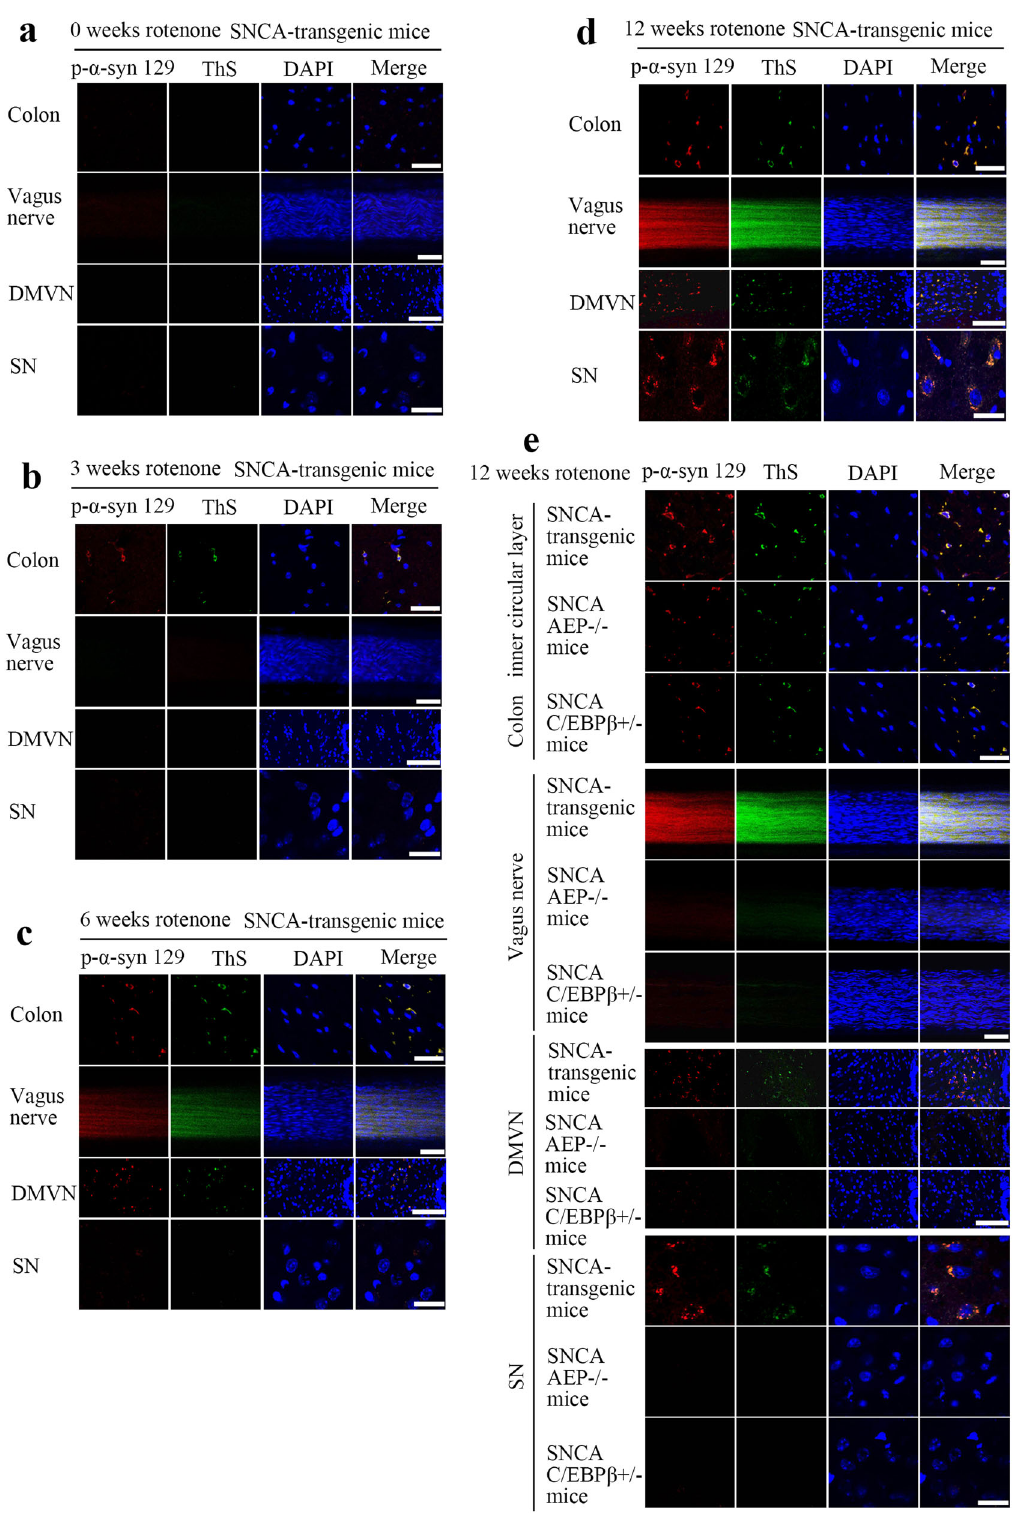
Fig. 6 C/EBP β /AEP axis mediates Lewy body-like pathology propagation from the gut into the brain in α -SNCA mice. Immuno fl uorescent co-staining of p- α -Syn 129 and ThS in the colon (Scale bar, 20 μ m), vagus nerve (Scale bar, 50 μ m), DMVN (Scale bar, 100 μ m), and SN (Scale bar, 20 μ m) in the α -SNCA transgenic mouse after 0-week ( a ), 3 weeks ( b ), 6 weeks ( c ), and 12 weeks ( d ) rotenone treatment. e Reduction of C/EBP β and knockdown of AEP block the spreading of p- α -Syn 129 co-stained with